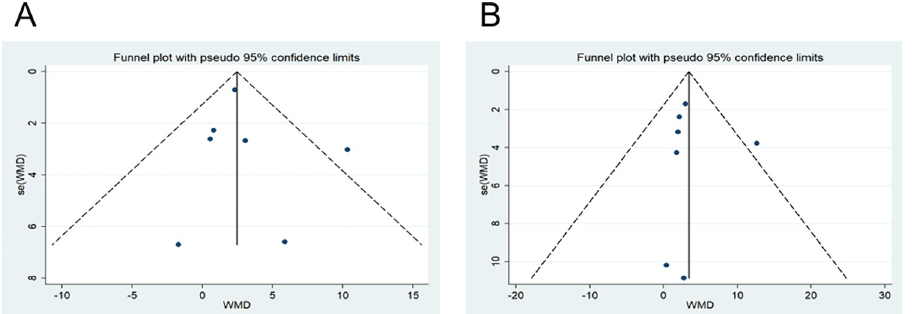
Fig 8. Funnel diagram of GMFM88-D and